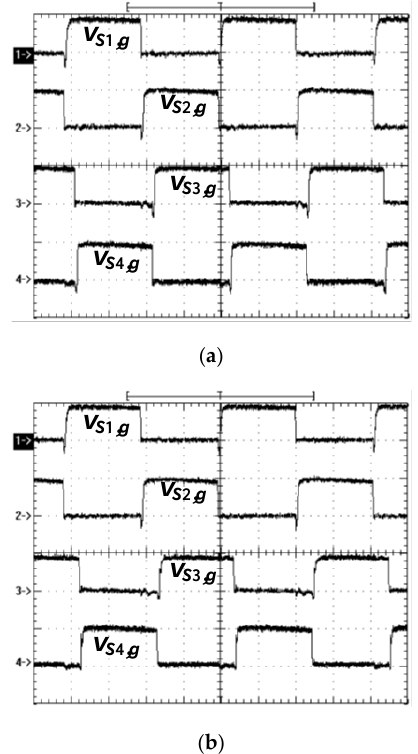
Figure 6. Measured gate voltages of S 1 ~S 4 in first full bridge circuit at full load and ( a ) V in = 750 V and ( b ) V in = 800 V (v S1,g ~v S4,g : 10 V / div; time: 4 µ s / div).